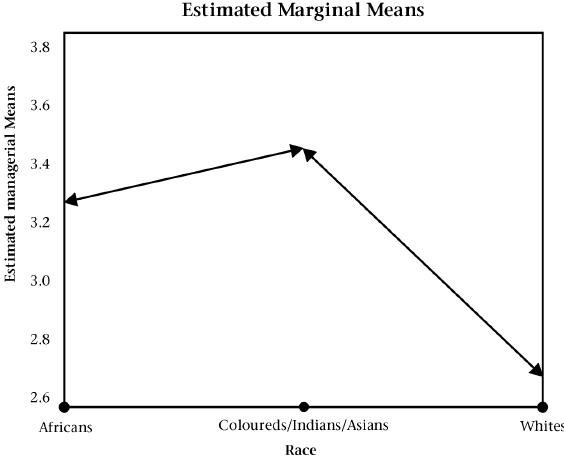
Figure 6:Biographical variable: Race as predictor of the